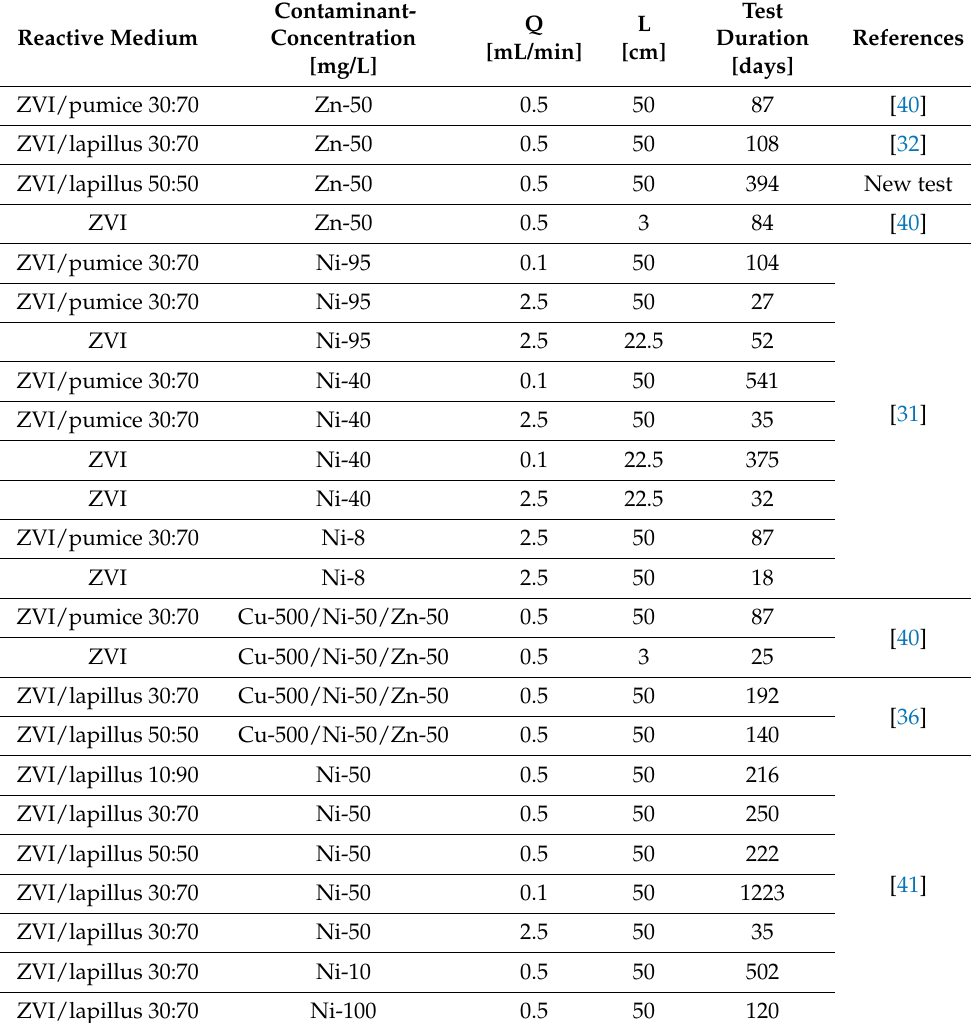
Table 1. Main data of the column